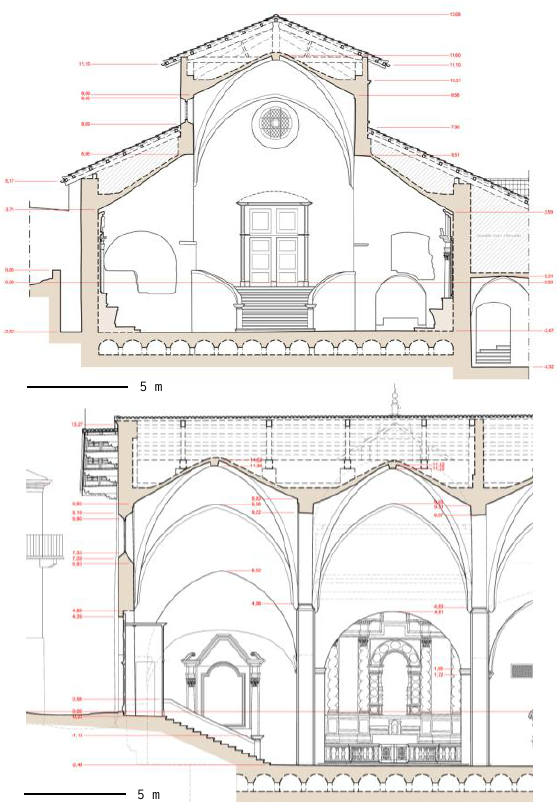
Figure 6. Vertical sections employed for the 3D modelling phase